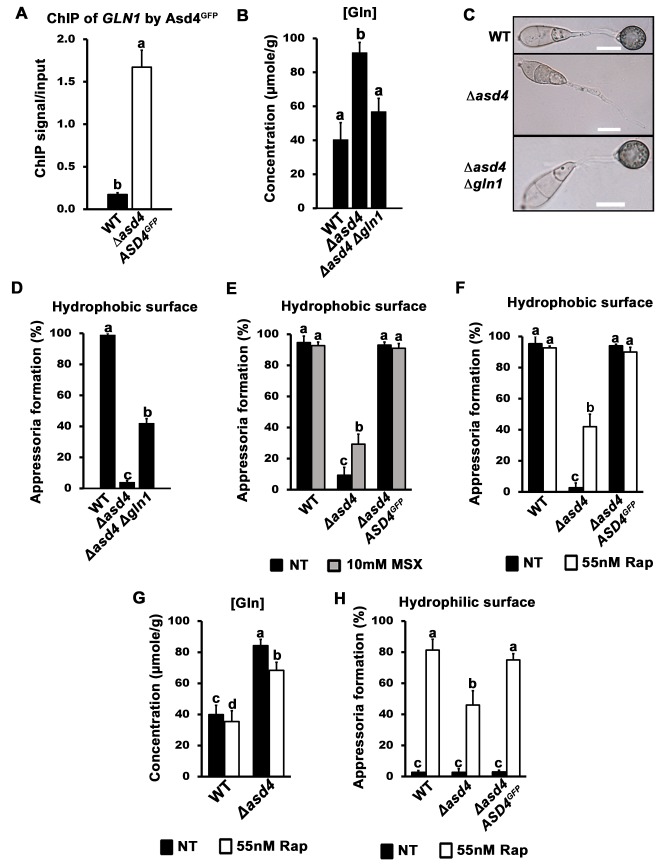
A real or perceived reduction in intracellular glutamine levels restores appressorium formation to Δasd4 mutant strains.(A) Asd4 physically interacts with the GLN1 promoter in vivo following growth on GMM with 10 mM NH4
+ as the sole nitrogen source. ChIP was performed using Anti-GFP. The eluted GLN1 DNA signal, normalized against the input control, was significantly (Student’s t-test p ≤ 0.05) enriched in Δasd4 ASD4GFP ChIP samples compared to WT controls lacking Asd4GFP. (B) Steady-state intracellular concentrations of glutamine were quantified using LC-MS/MS analysis of amino acid extracts from dried fungal mycelia of the indicated strains following growth on GMM + 10 mM NH4
+ media. Values are the average of three independent biological replicates. (C) Appressorial development of WT, Δasd4 and Δasd4 Δgln1 strains on artificial hydrophobic surfaces (coverslips) at 24 hpi. Scale bar is 10 μm. (D) Appressorial formation rates of WT, Δasd4 and Δasd4 Δgln1 mutant strains on artificial hydrophobic surfaces (coverslips). (E) Treatment of Δasd4 spores with the glutamine synthetase inhibitor 10 mM L-methionine sulphoximine (MSX) partially remediated appressorium formation. (F) Δasd4 mutant strains formed appressoria at 24 hpi on artificial hydrophobic surfaces following treatment with 55 nM rapamycin (Rap). (G) Steady-state intracellular concentrations of glutamine were quantified following growth of the indicated strains on GMM + 10 mM NH4
+ media with and without 55 nM rapamycin. Values are the average of three independent biological replicates. (H) Treating spore suspensions with 55 nM rapamycin induced appressorium formation by WT and Δasd4 mutant strains on non-inductive hydrophilic surfaces. NT is untreated. (A-B, D-H) Error bars are standard deviation. Bars with different letters are significantly different (Student’s t-test p ≤ 0.05). (D-F, H) Values are the average of the number of appressoria formed at 24 hpi from 50 spores per coverslip, repeated in triplicate.